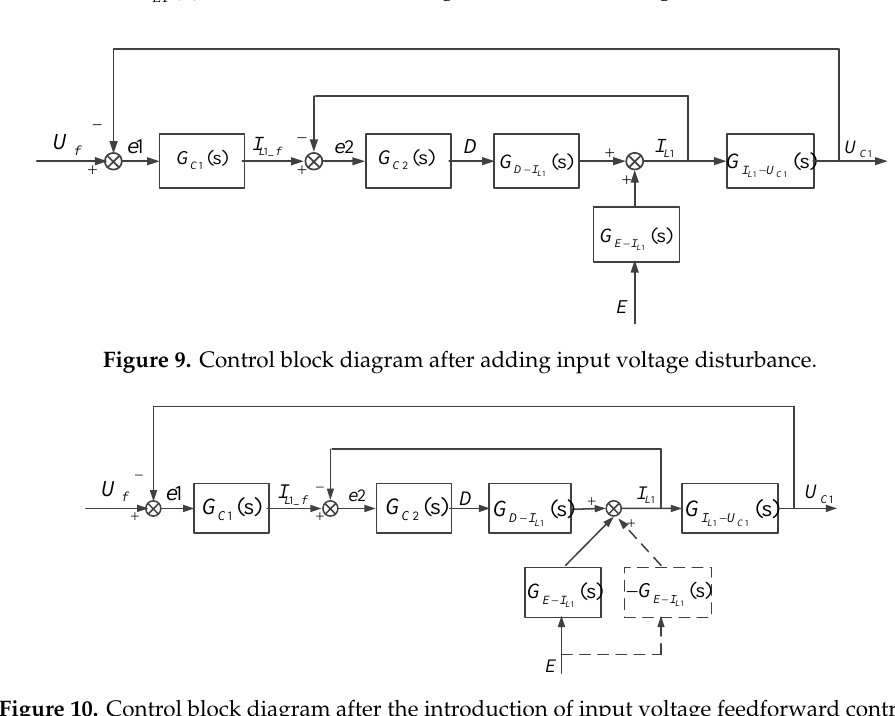
Figure 10. Control block diagram after the introduction of input voltage feedforward control.